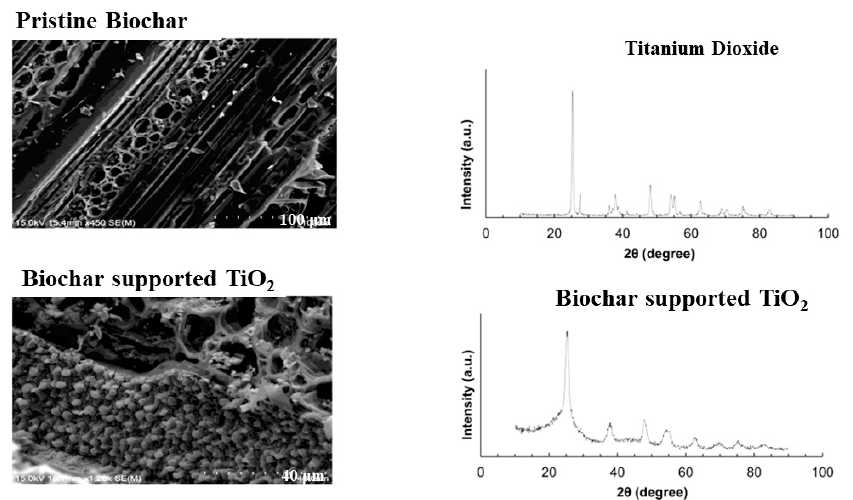
Figure 7. SEM and XRD pattern of the pristine biochar and biochar-supported TiO 2 nanoparticle (reproduced with permission from [38] Copyright Year 2016, Journal of Environmental Management © Elsevier Pvt Ltd. License number 5122010796759).